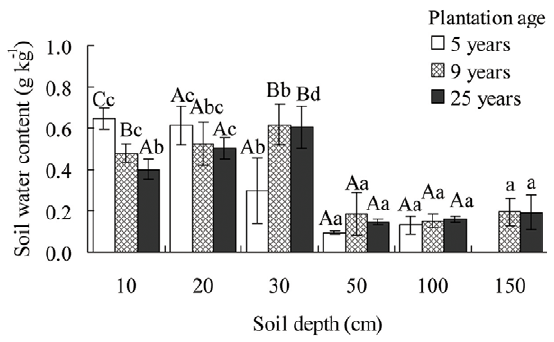
Figure 2. Soil water content (mean ± SE) of sand dunes in three different ages of Caraganaintermedia plantations. Four replicates of soil sample was take by soil auger in each age of C. intermedi a plantations. Different lowercase letters indicate significant difference in water content at different soil depths, and different uppercase letters indicate significant difference in water content in different plantation ages, according to Duncan’s test ( p ,